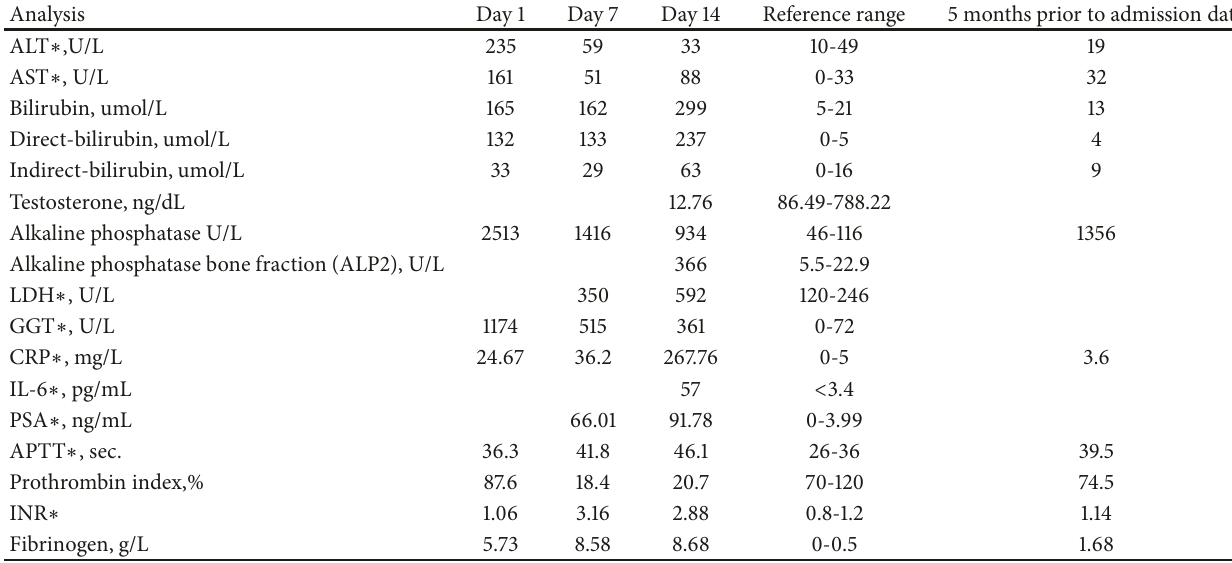
Table 1: Laboratory findings during